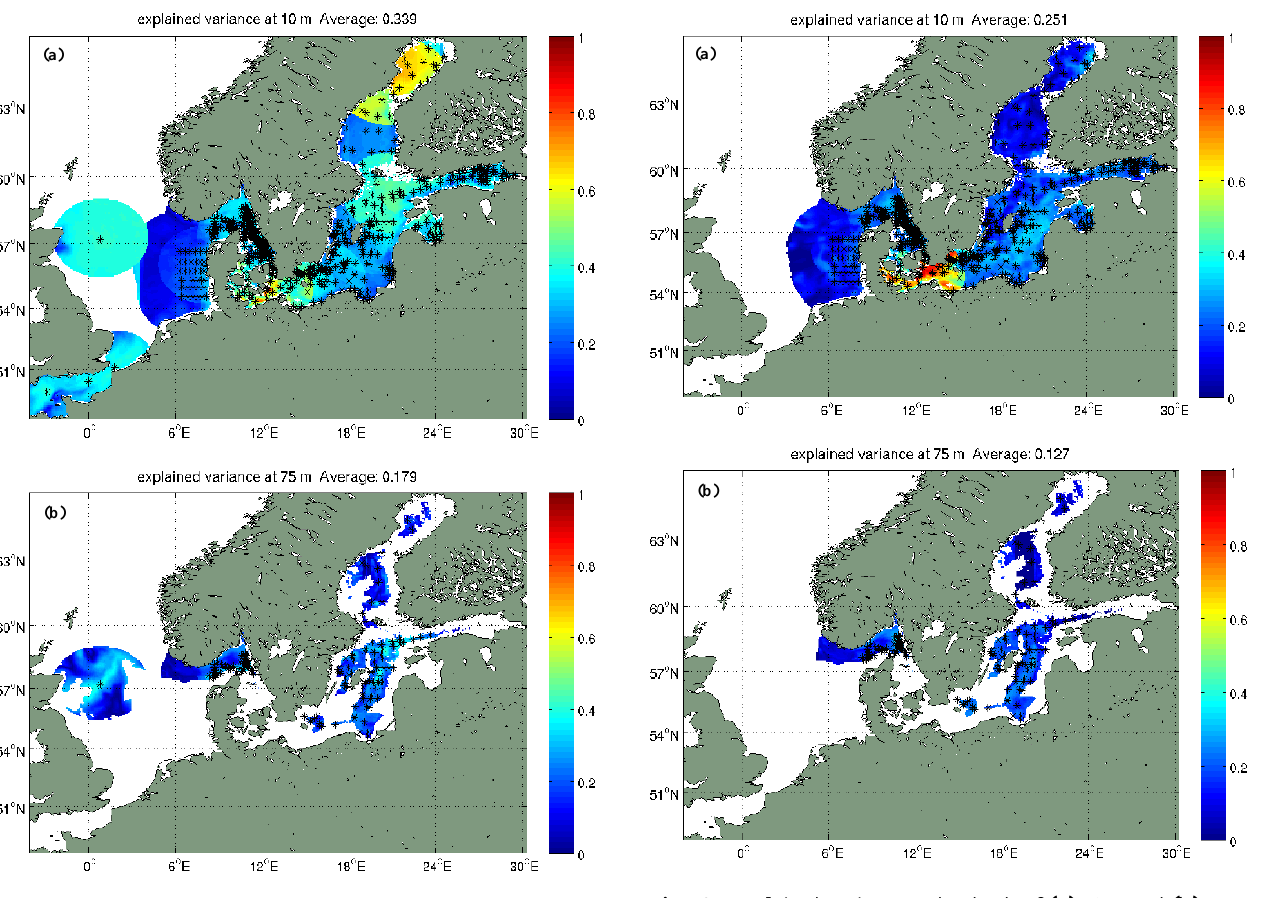
Fig. 11. Explained variance at the depth of (a) 10m and (b) 75m for temperature.